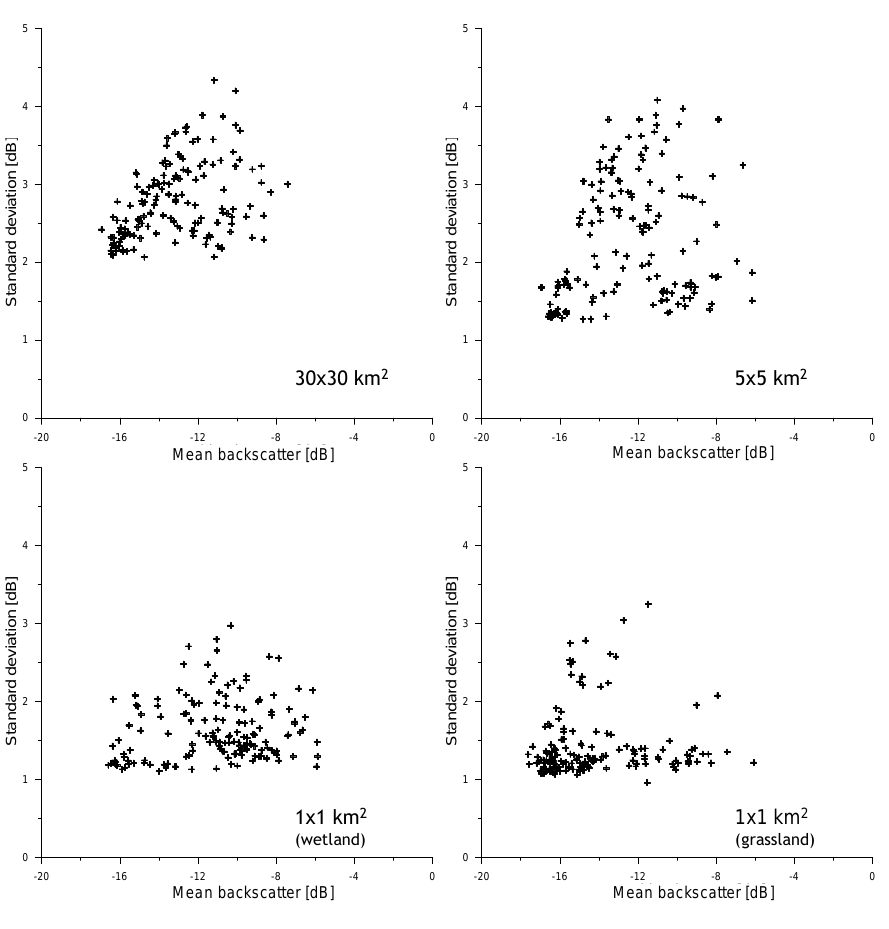
Figure 3. Standard deviation in σ o observations plotted against the mean σ o extracted from the ASAR WSM time series and four different spatial domains around Naqu